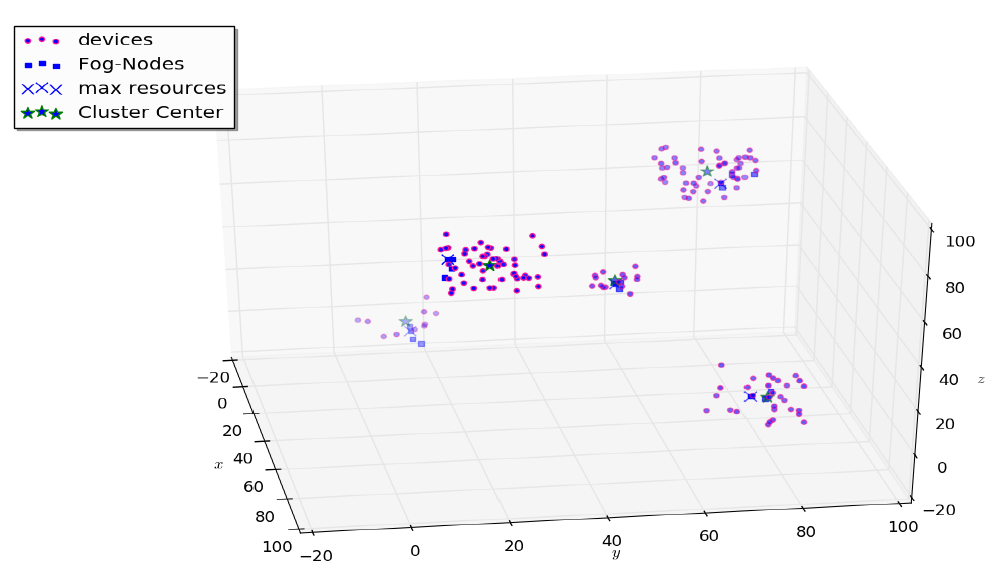
Figure 10. Algorithm results (position